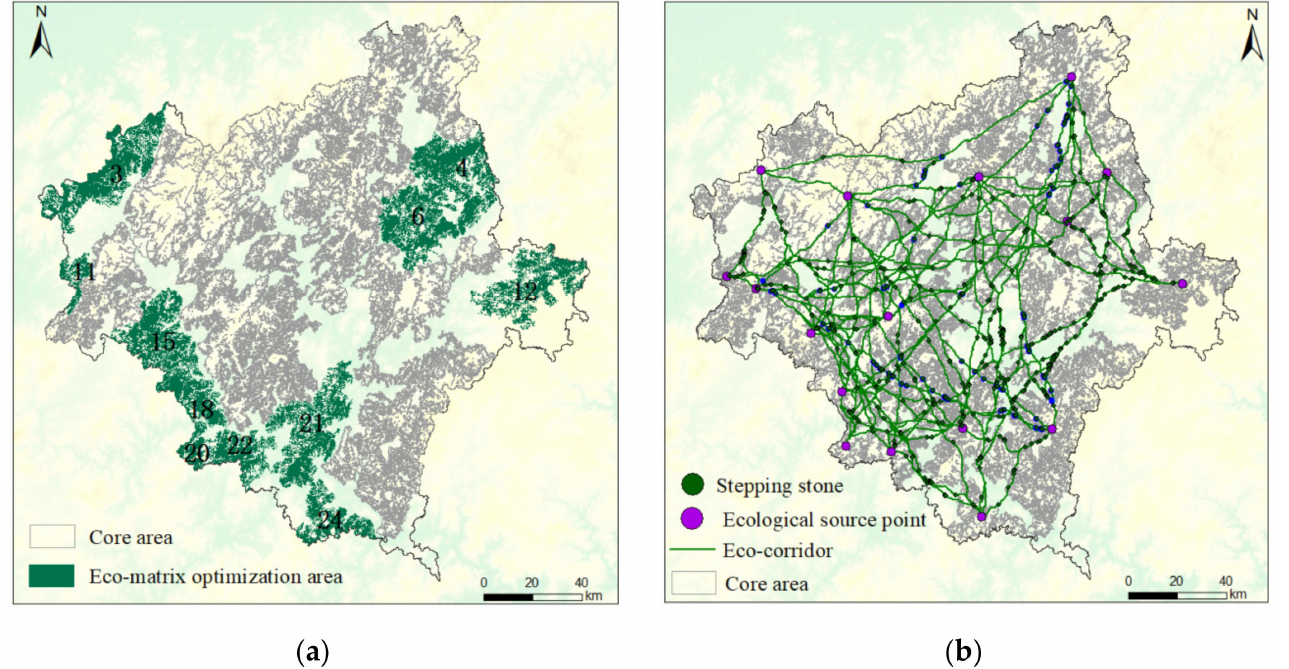
Figure 9. Spatial distribution of the optimized ( a ) eco-matrix and ( b )